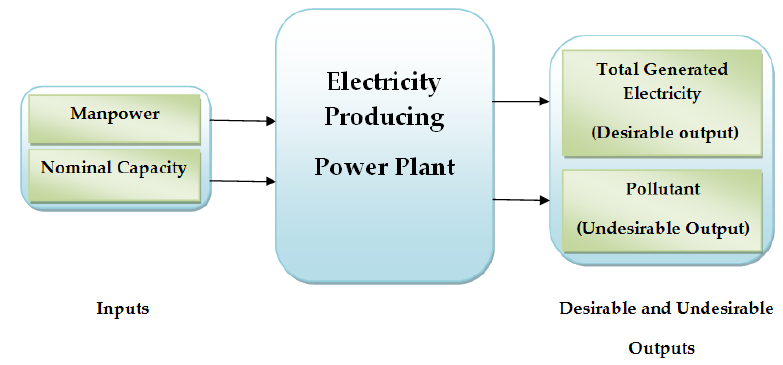
Figure 1. The structure of a power plant as a decision-making unit.